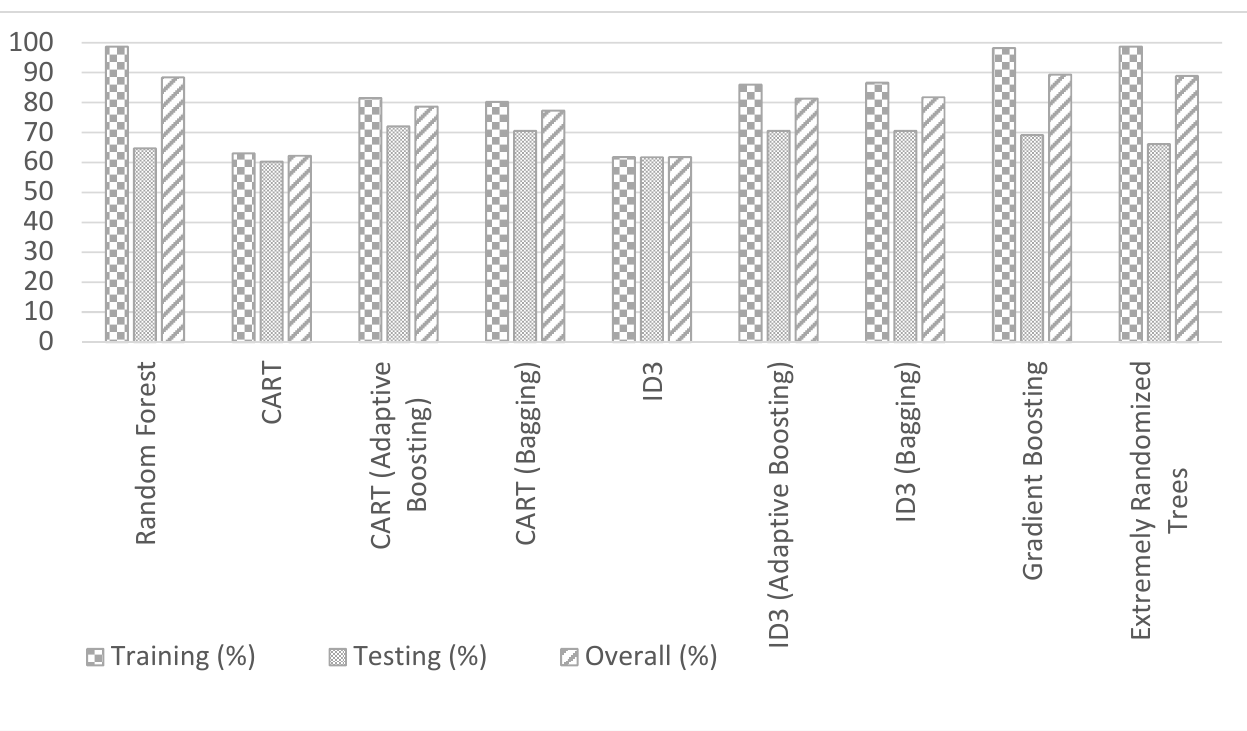
Figure 6. Bar graph of training, testing, and overall accuracies of different DT models.